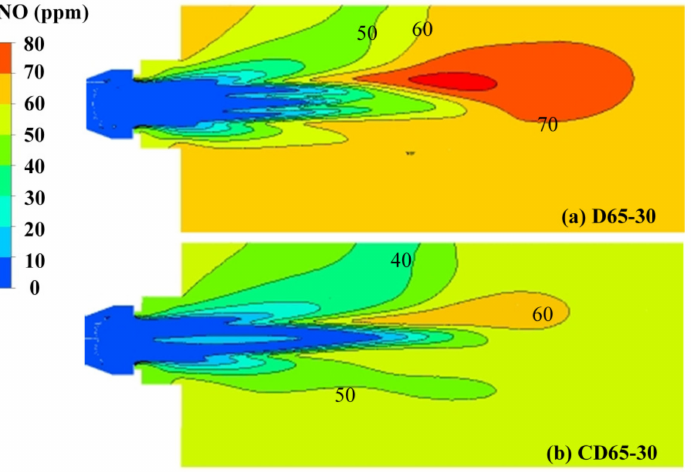
Figure 10. Local distribution of NO x concentration (ppm) of D65-30 and CD65-30 on the central cross section.